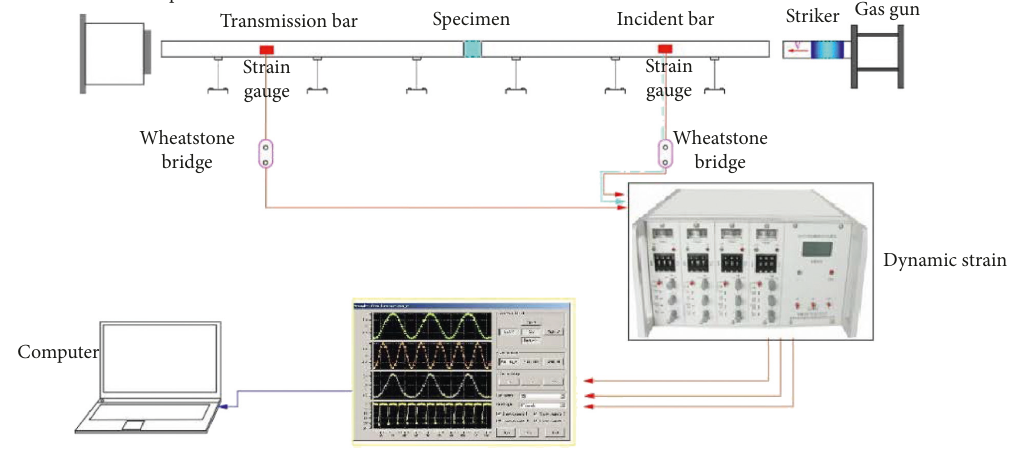
Figure 4: Schematic illustration of the SHPB device.